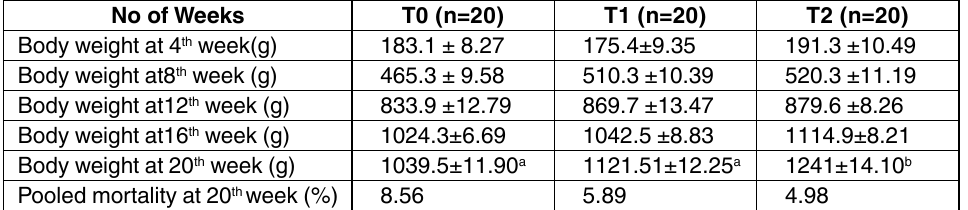
table 2. Impact of fresh Azolla supplementation on body weight gain of Pratapdhan strain No of Weeks t0 (n=20) t1 (n=20) t2 (n=20) Body weight at 4 th week(g) Body weight at8 th week